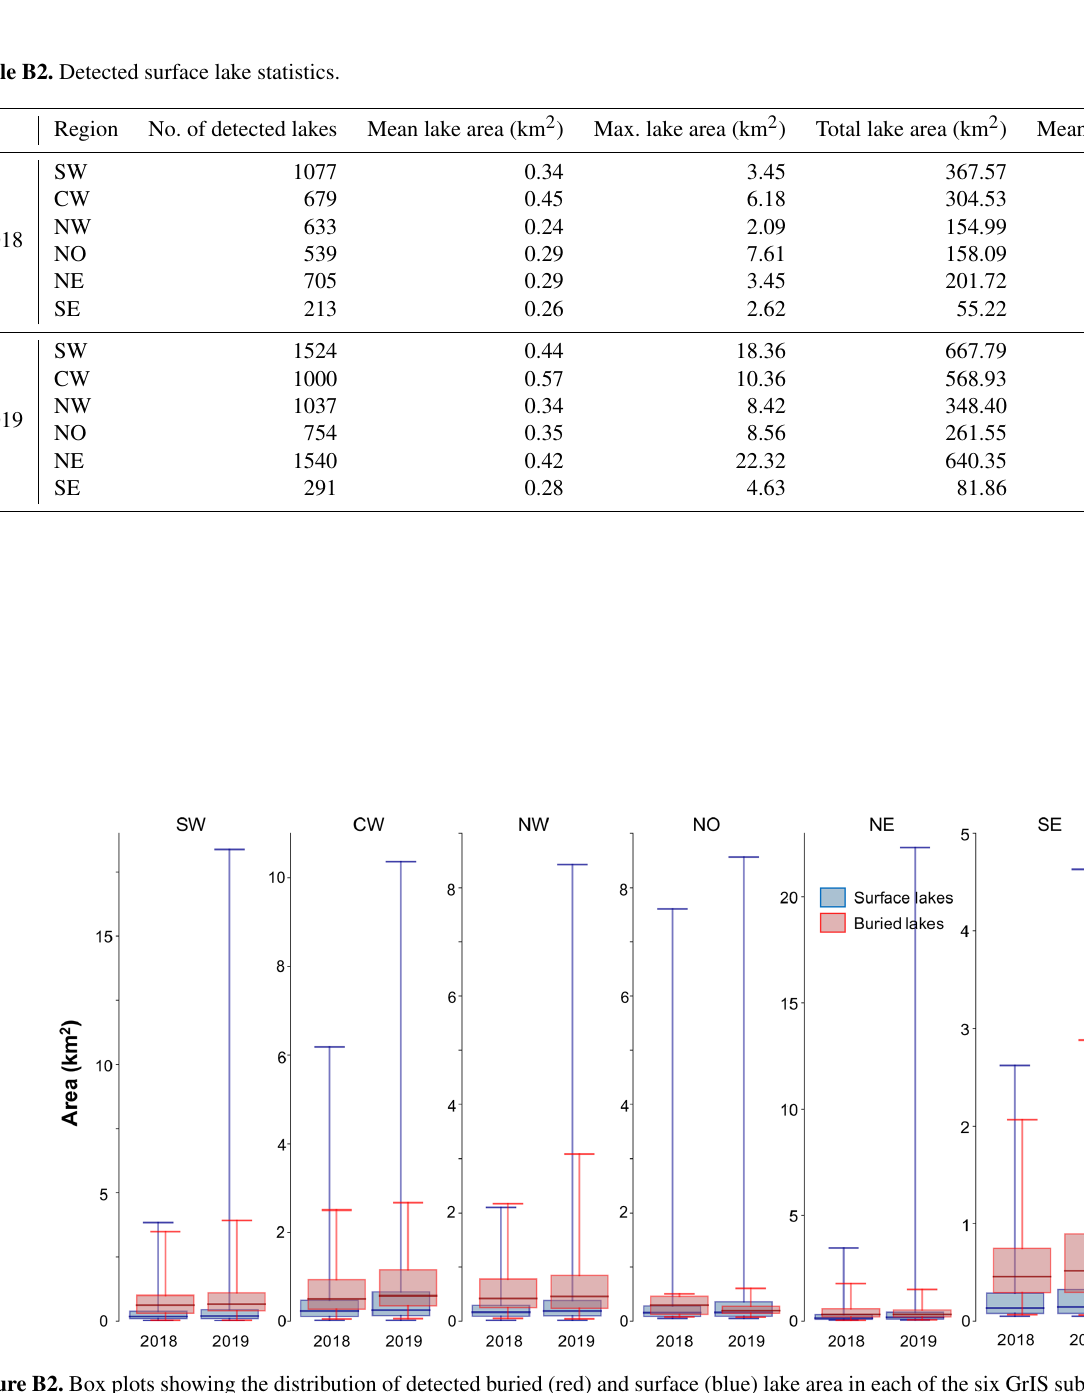
Figure B2. Box plots showing the distribution of detected buried (red) and surface (blue) lake area in each of the six GrIS subregions. Boxes represent the interquartile range of lake area, and whiskers represent the entire range of lake area in a given